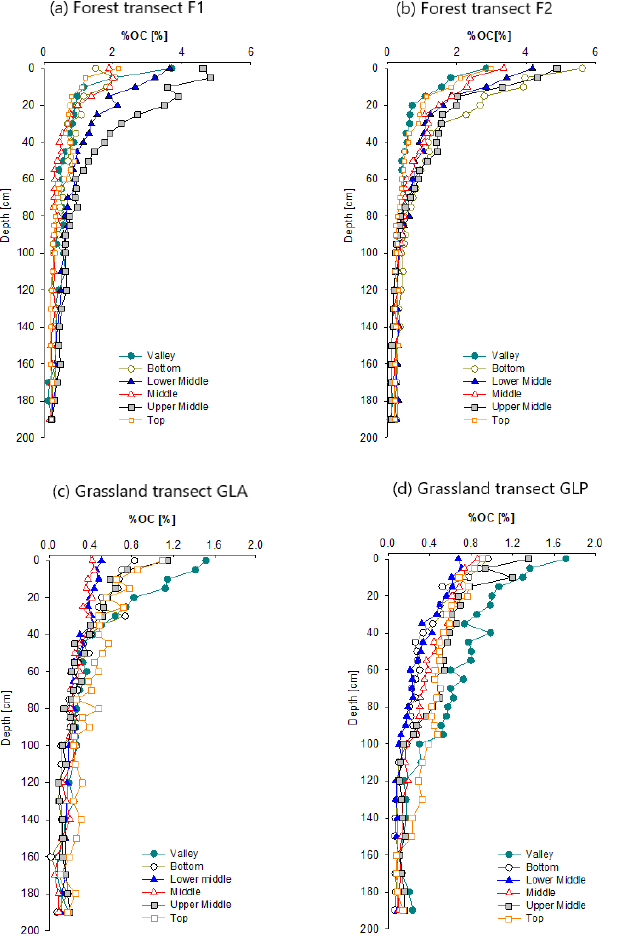
Figure 2. Depth profiles of%OC for each sampling location (top, upper middle, middle, lower middle, bottom, valley) of the four transects including F1 (a) , F2 (b) , GLA (c) and GLP (d) .